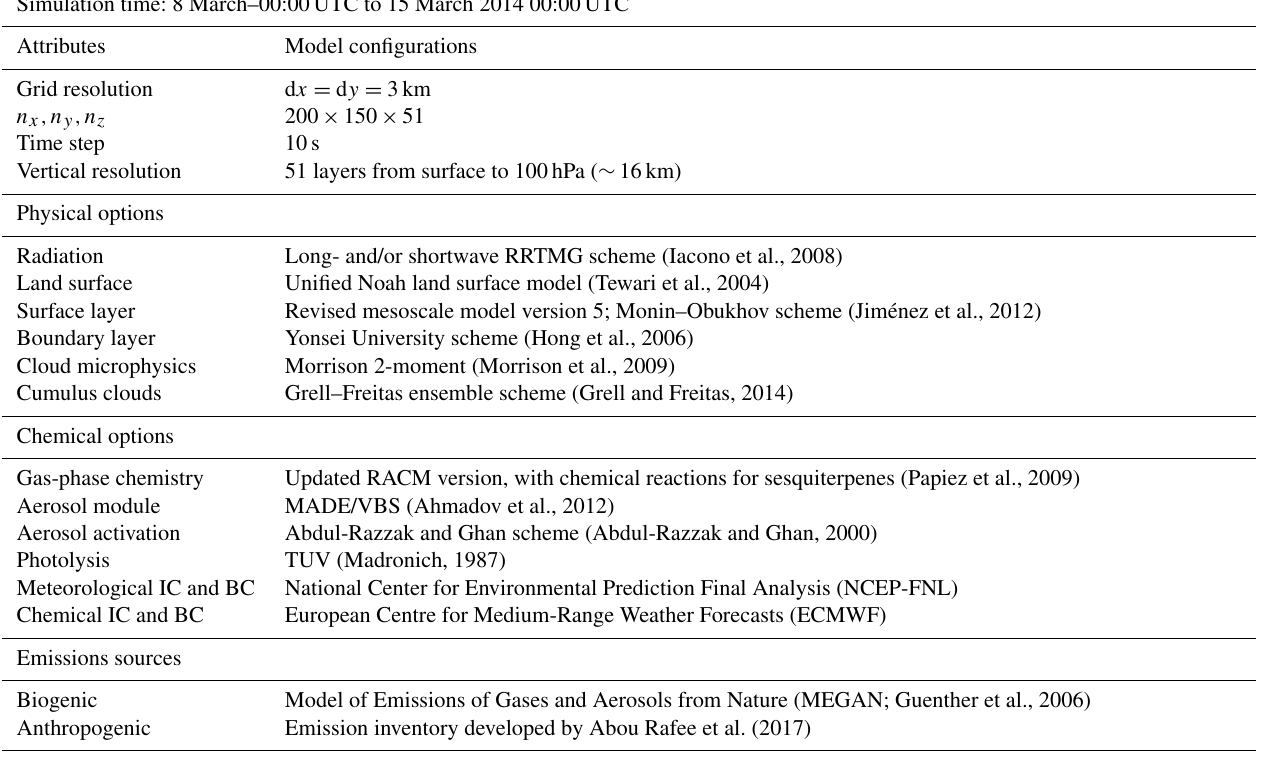
Table 1. WRF-Chem simulations configuration used in this